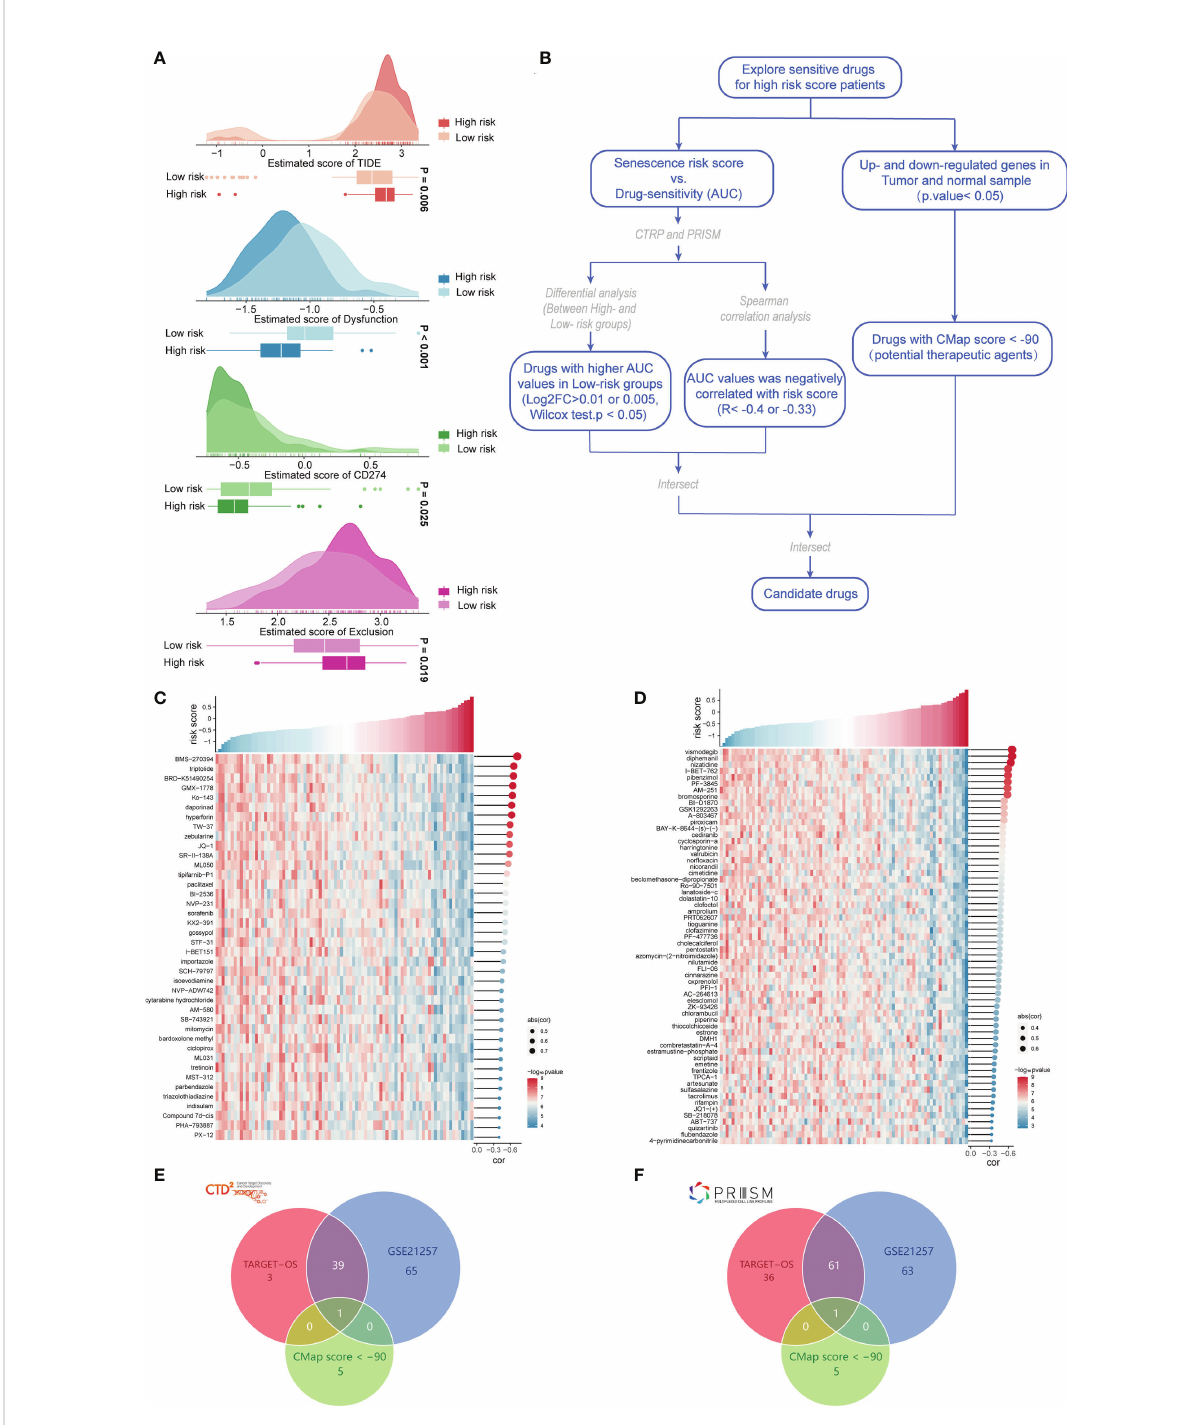
FIGURE 7 Evaluation of immunotherapy and screening of chemotherapeutic drugs. (A) Prediction of ICB treatment response of osteosarcoma based on the TIDE, dysfunction, CD274, and exclusion scores. (B) Flow chart of chemosensitivity prediction based on the osteosarcoma risk score. (C) Heatmap of the sensitivity of 40 chemotherapeutic drugs screened in the CTRP database. (D) Heatmap of the sensitivity of 62 chemotherapeutic drugs screened in the PRISM database. (E) Intersection with drugs with CMap scores< − 90 in the CTRP database. (F) Intersection with drugs with CMap scores< − 90 in the PRISM